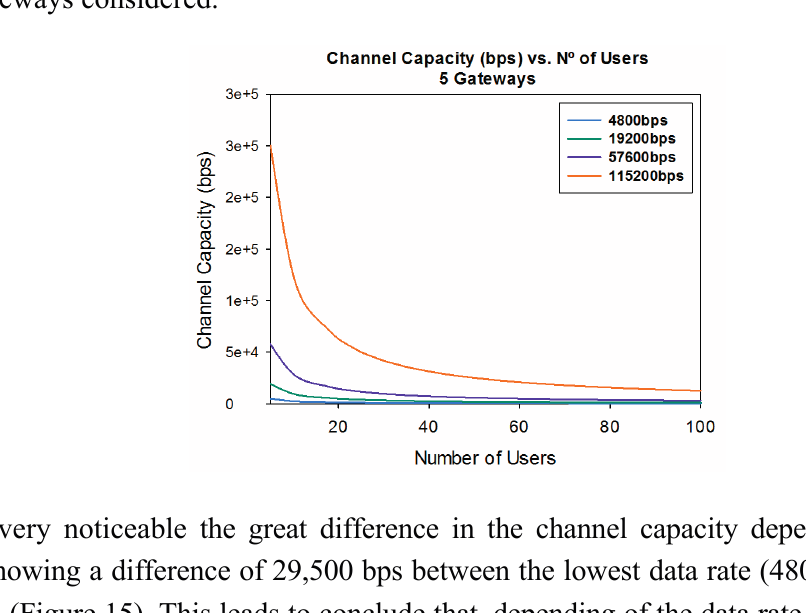
Figure 15. Channel capacity (bps) vs. the number of users for different data rates for five gateways